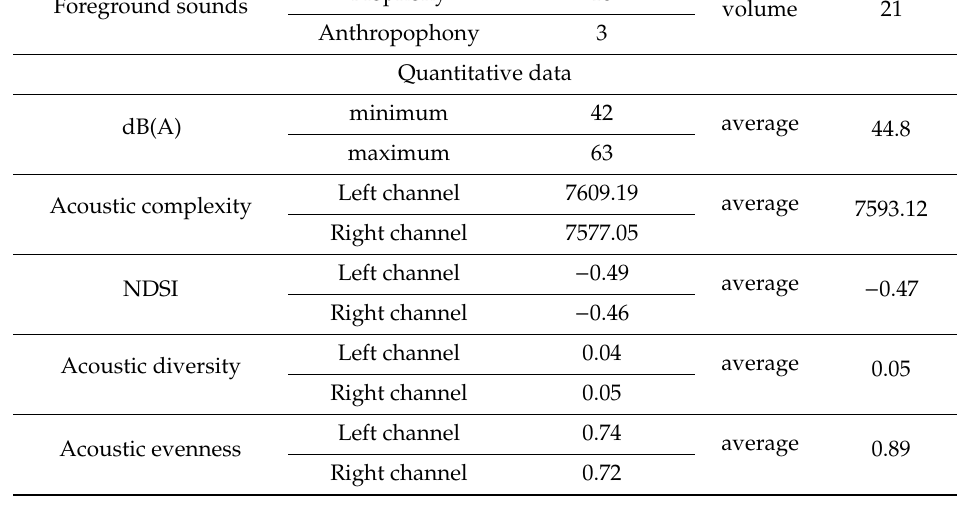
NDSI highlighted the fact that anthropophonic sounds prevailed.